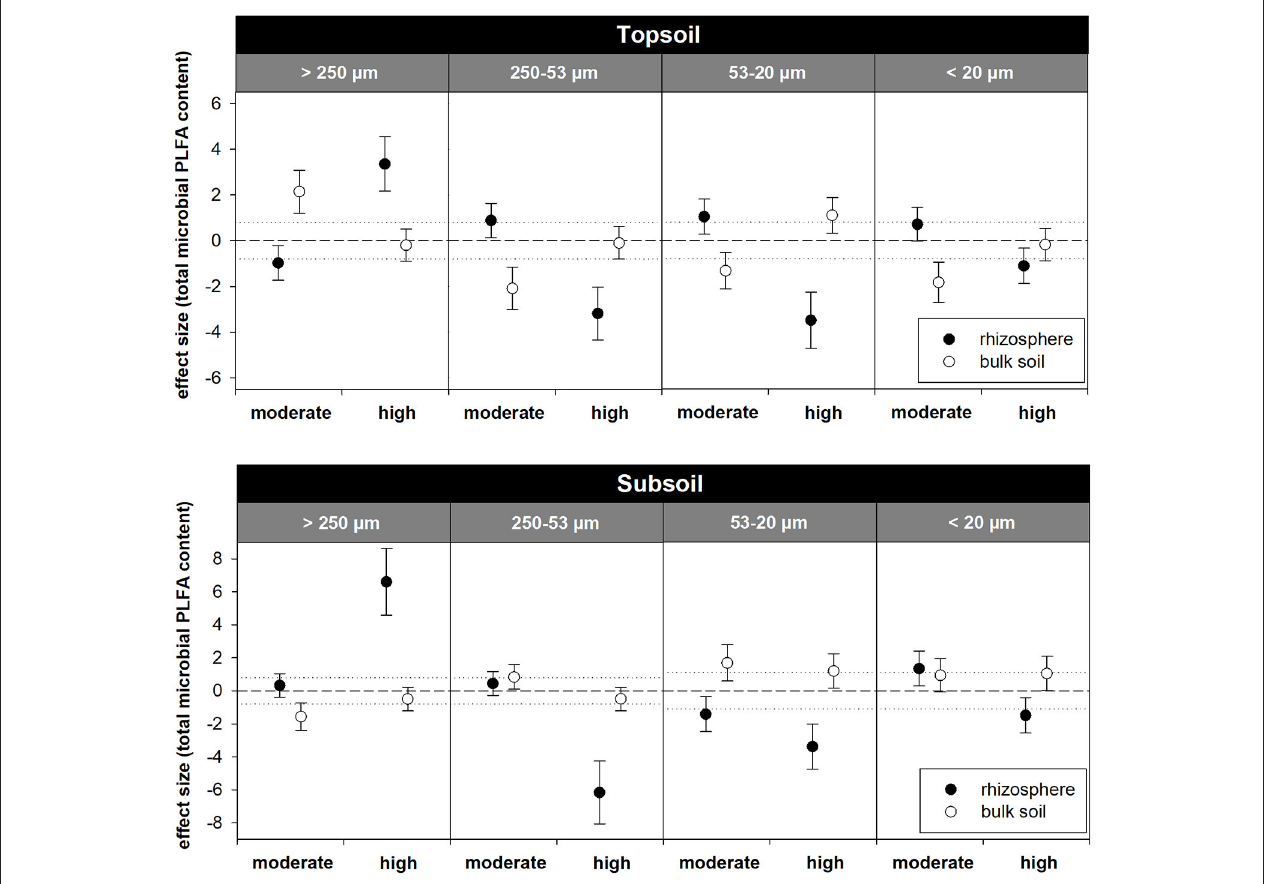
FIGURE 6 | Standardized effect sizes for the distribution of water-stable aggregate size classes. Hedges’ g* of the exudate addition treatments compared to the water control. Bars indicate the standard error of the effect size estimate. Dotted lines mark thresholds of − 0.8 and 0.8 below or above which, respectively, effect sizes are considered as